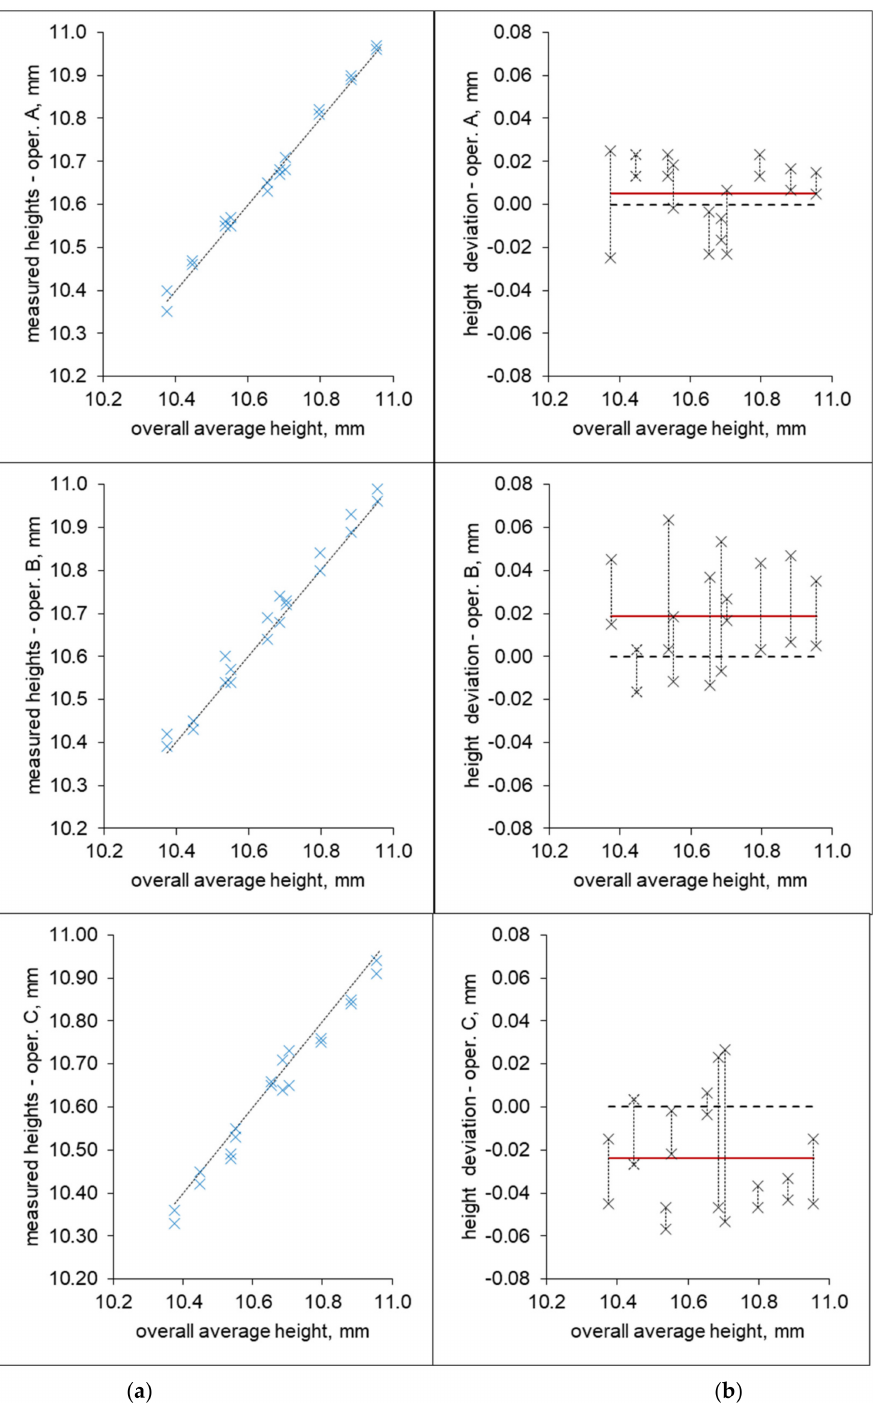
Figure 3. Scatter plots and modified GRR diagrams for individual operators: ( a ) scatter plots; ( b ) modified GRR